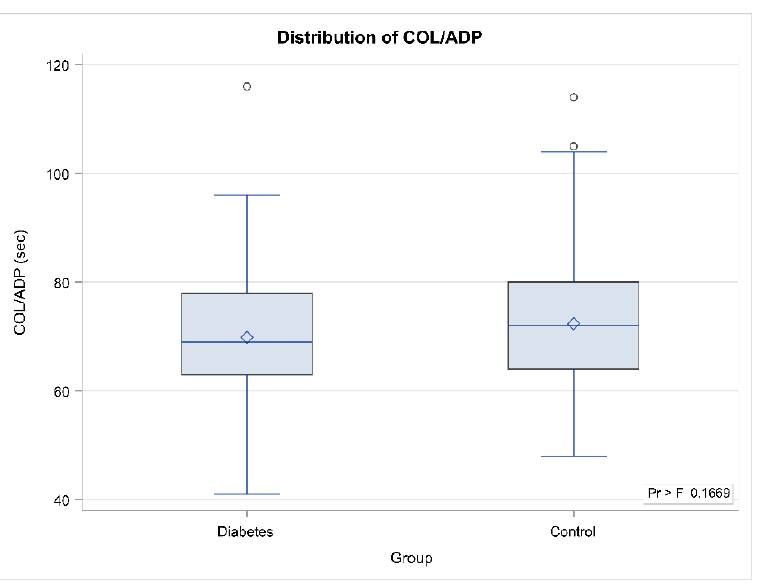
Figure 1. Box and whisker plots for COL/EPI CT (above) and COL/ADP CT (below) between the study group ( n = 84) and the control group ( n = 118). Whisker limits show minimum and maximum values (excluding outliers that appear as circles), 25th and 75th percentile are the box lower and upper parts, while median and mean values appear as the horizontal line inside the box and the diamond symbol, respectively.